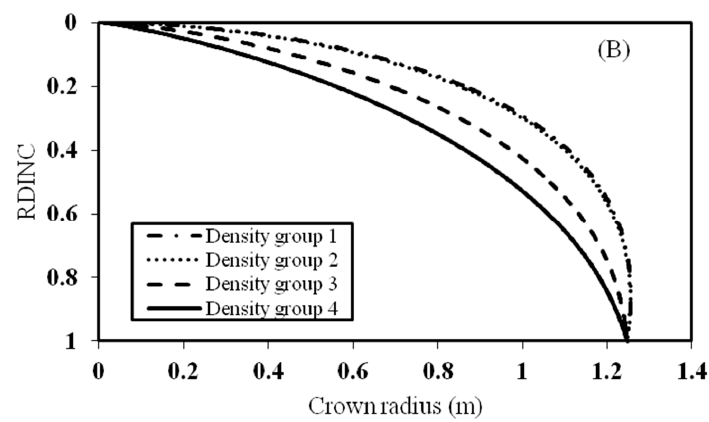
Figure 2. Effects of stand age and stand density on the crown profile based on the dummy variable approach. ( A ) reflects the effect of stand age on the crown profile and ( B ) reflects the effect of stand density on the crown profile. Age group 1 represents the stand age lower than 20 years, Age group 2 between 21 and 30 years, Age group 3 of 31–40 years, and Age group 4 between 41 and 60 years. Density group 1 represents the stand density lower than 1000 trees ha − 1 ; Density group 2 between 1000 and 2000 trees ha − 1 ; Density group 3 between 2000 and 3000 trees ha − 1 , and Density group 4 of larger than 3000 trees ha − 1 .